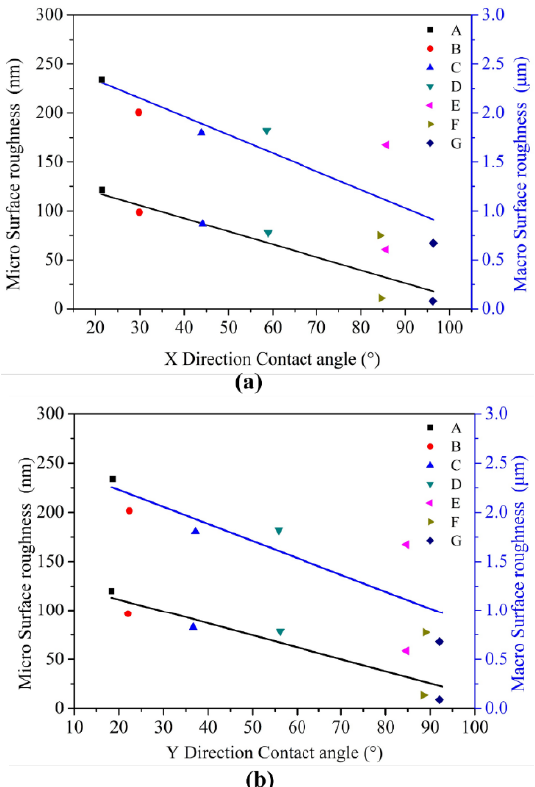
Figure 6. Relationship between contact angle of the present specimen A – G and micro and macro roughness with ( a ) X direction and ( b ) Y direction. The linear equation of the surface X direction contact angle and microscopic surface roughness is y = − 0.02 x + 2.71 (slope is − 0.02). The linear equation of the surface contact angle and macroscopic surface roughness is y = − 1.32 x + 145.36 (the slope is − 1.32). The linear equation of the surface Y direction contact angle and microscopic surface roughness is y = − 0.01 x + 2.57 (slope is − 0.01). The linear equation of the surface contact angle and macroscopic surface roughness is y = − 1.22 x + 135.76 (the slope is − 1.22) (Specimen A—electropolished for 300